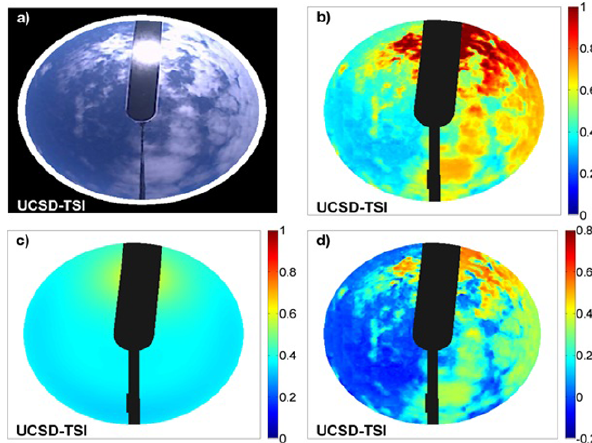
Fig. 4. (a) True-color image captured by the TSI on 12:10PST, 20 February 2011 (b) RBR of the image for FOV < 140 ◦ (c) Clear Sky RBR generated from the CSL on 12 February 2011. (d) RBR difference (Diff) between image RBR and CSL